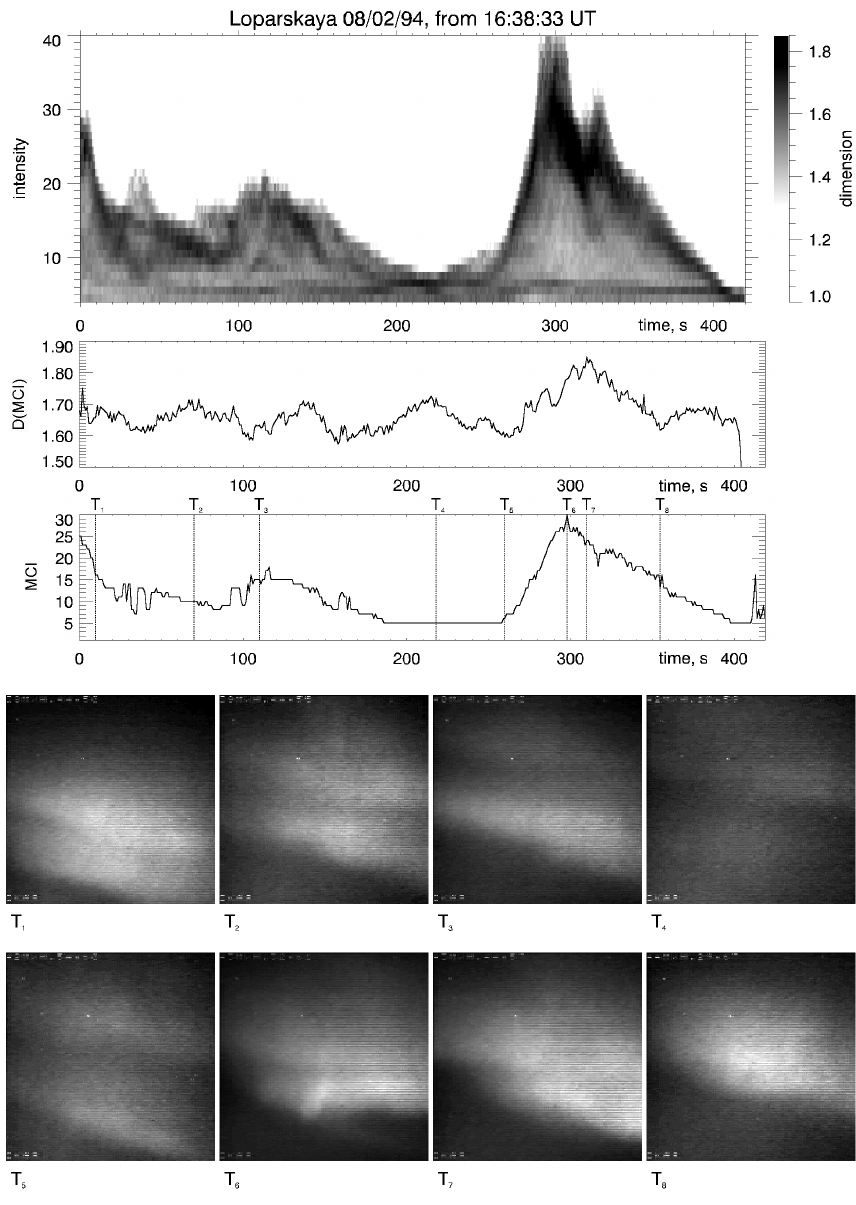
Fig. 11. The same as Fig. 9, but for event 3.